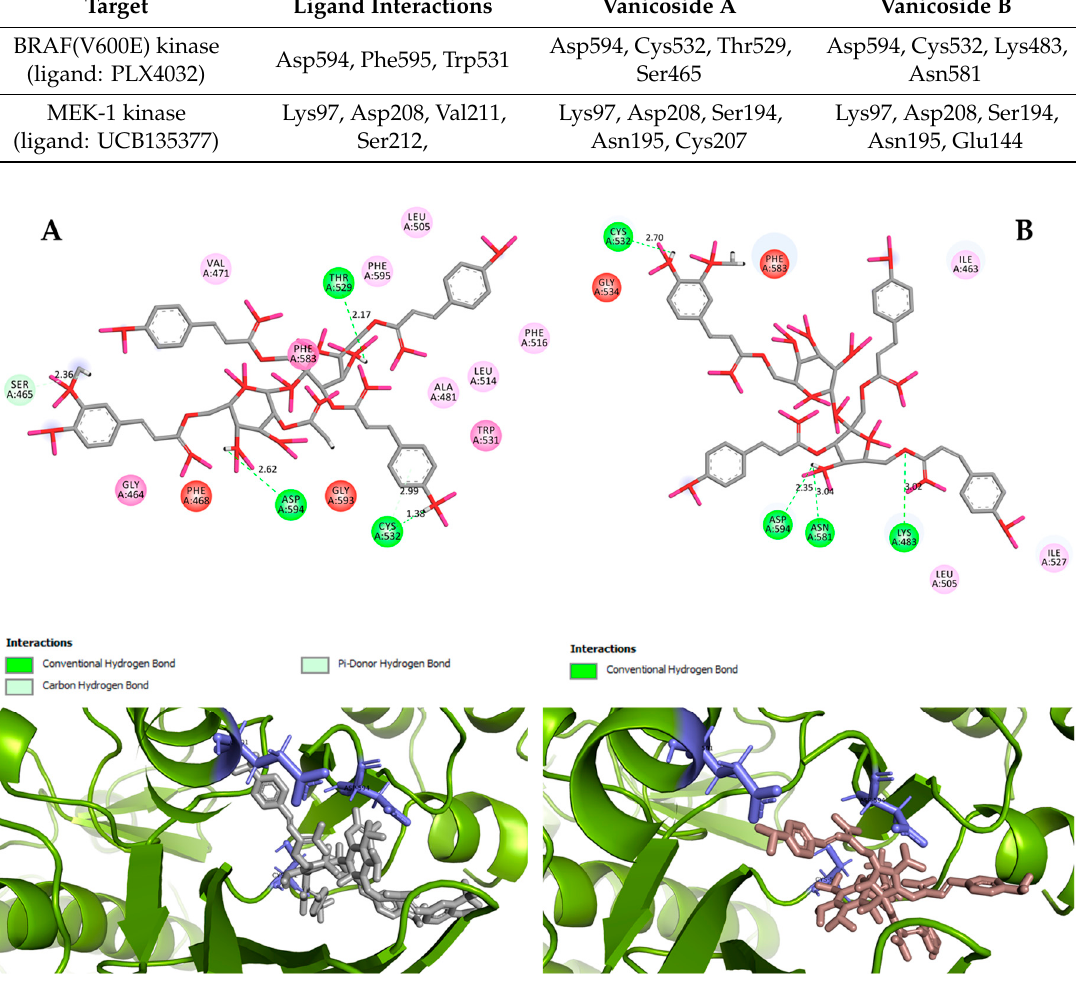
Figure 7. 2D and 3D interactions of vanicoside A ( A ) and vanicoside B ( B ) with the B-Raf kinase.